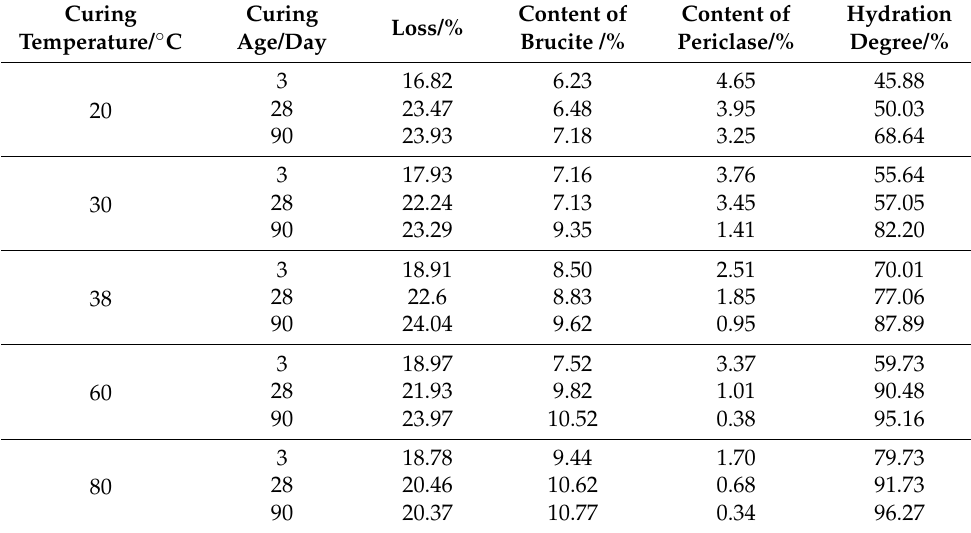
Table 5. The hydration degree of MgO (65 s) in cement